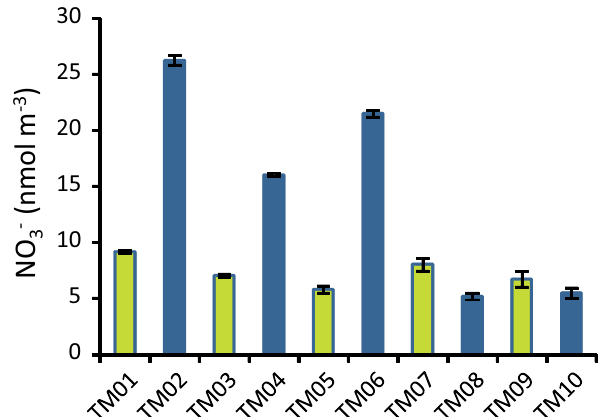
Figure 3. Aerosol nitrate concentrations (nmolm − 3 ) during M91.